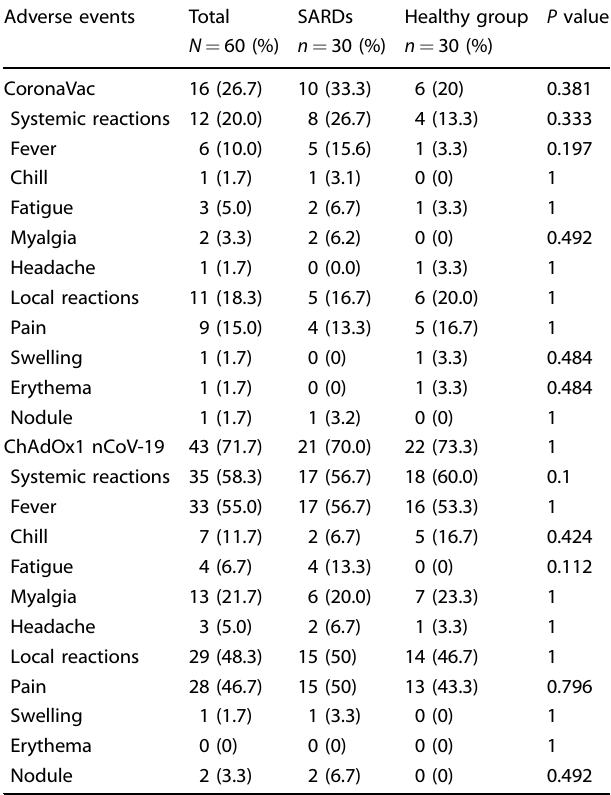
Table 1. Demographic characteristics of patients with systemic autoimmune rheumatic diseases (ARDs) and the healthy group. Baseline characteristics